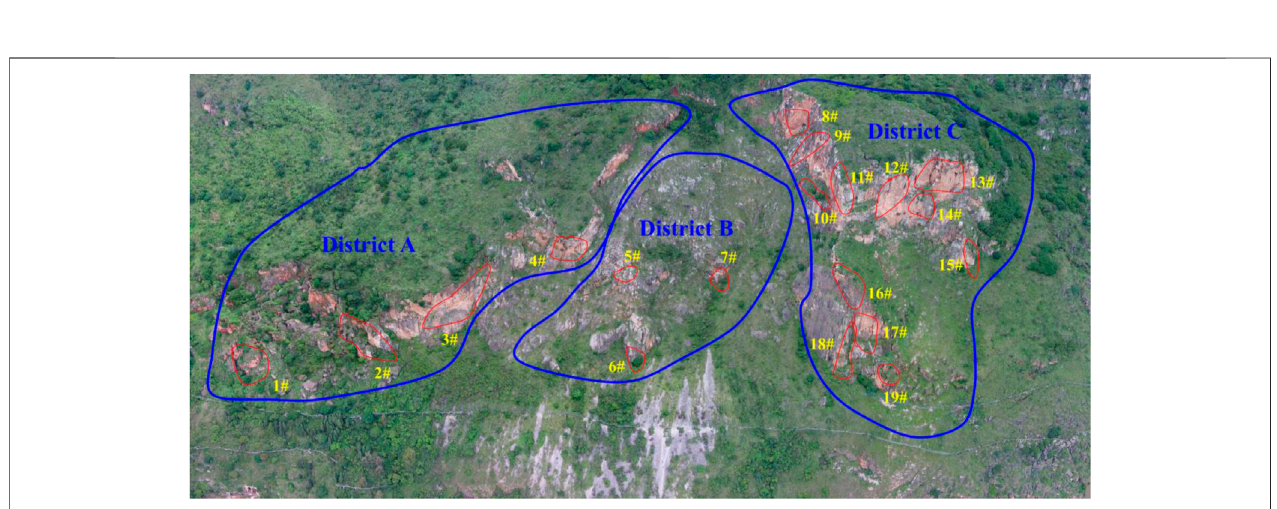
FIGURE 3 | Panoramic high-precision 3D model of the rockfall used as a case study.